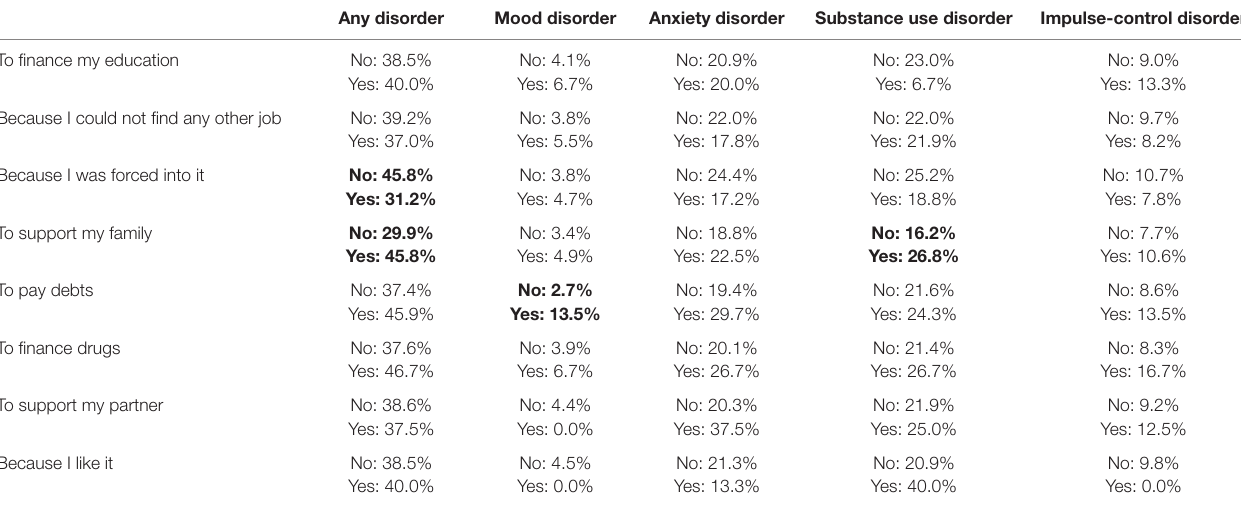
TaBle 3 | relationship between prevalence of DsM-iV mental disorders and reported motives for employment as an FsW.